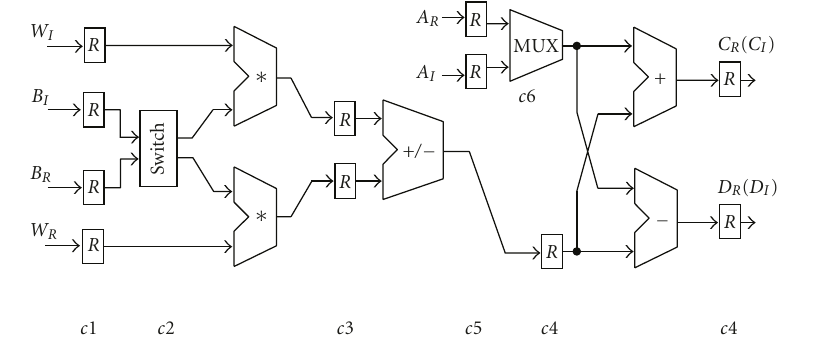
Figure 7: Proposed pipelined radix-2 butterfly unit.